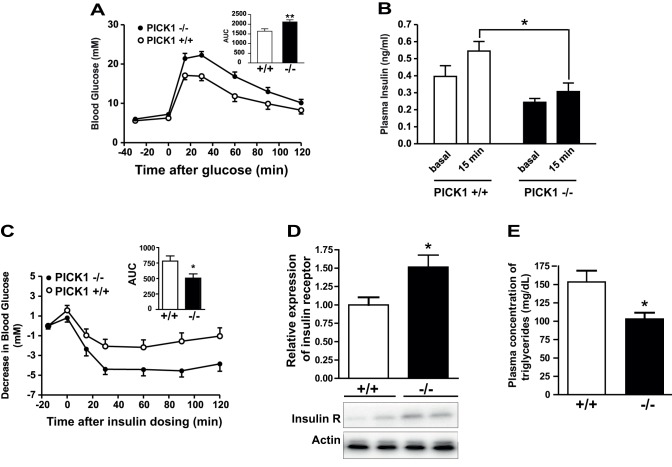
Dysregulation of glucose homeostasis in PICK1-deficient mice.(A) Impaired glucose tolerance in PICK1-deficient mice. OGTT was done in 10–13-wk-old WT (+/+) and PICK1-deficient mice (−/−) after overnight fast. White circles, PICK1 +/+; black circles, PICK1 −/−. The inset shows area under curve (AUC). Data are means ± SE (n = 9). **p<0.01. (B) Mice deficient in PICK1 display decreased insulin secretion during OGTT. White bars, PICK1 +/+: black bars, PICK1 −/−. Data are means ± SE. *p<0.05. (C) Mice deficient in PICK1 (27–29 wk) display preserved or even improved insulin sensitivity in the ITT. White circles, PICK1 +/+; black circles, PICK1 −/−. Data are means ± SE (n = 9–11). AUC was significantly lower for the PICK1-deficient mice compared to WT mice. *p<0.05. (D) The protein expression level of the insulin receptor as determined by quantification of Western blots on liver samples from 35–38-wk-old mice after overnight fasting was significantly increased in PICK1-deficient mice (−/−) compared to WT (+/+) mice (means ± SE, *p = 0.024). Western blots with insulin receptor and actin immunoreactivity of two representative samples out of 13 PICK−/− and 10 PICK+/+ samples are shown below. (E) The plasma levels of triglycerides (TG) after overnight fasting were significantly decreased in PICK1-deficient mice (−/−) compared to WT (+/+) mice (154±15 versus 103±9, n = 10–13, **p = 0.0056).